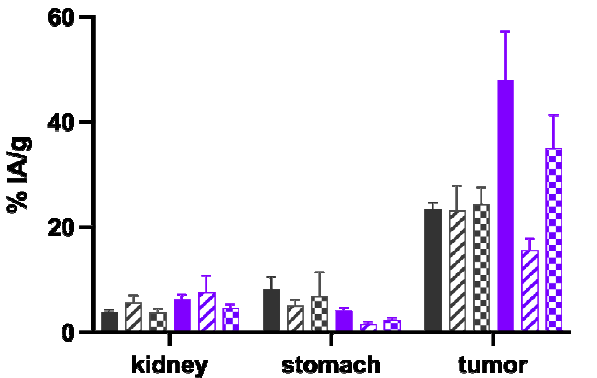
Figure 5. Uptake in kidney, stomach and A431-CCK2R xenografts of radiolabeled DOTA-[( N -